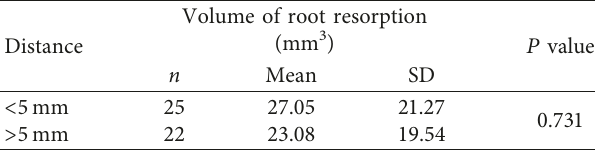
Table 3: Comparison of the MVR in terms of the angle between impacted canine and lateral incisor.